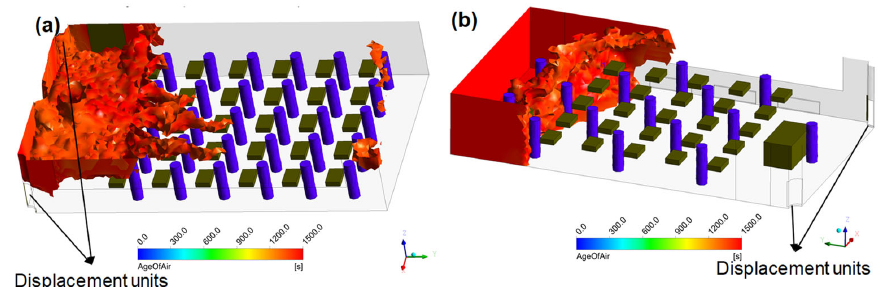
Figure 9. Locations in the occupied zone where age of air over 25% older than fully mixed with displacement unit ( a ) in summer conditions and ( b ) in winter